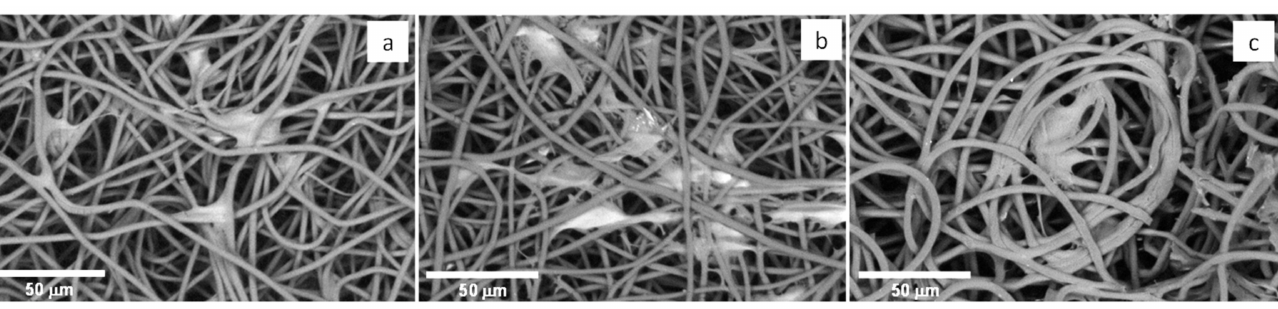
Figure 9. SEM images of HDFn attached to PHA-based electrospun scaffolds: ( a ) P(3HB), ( b ) P(3HB-co-3HV) and ( c ) P(3HB- co-3HV):